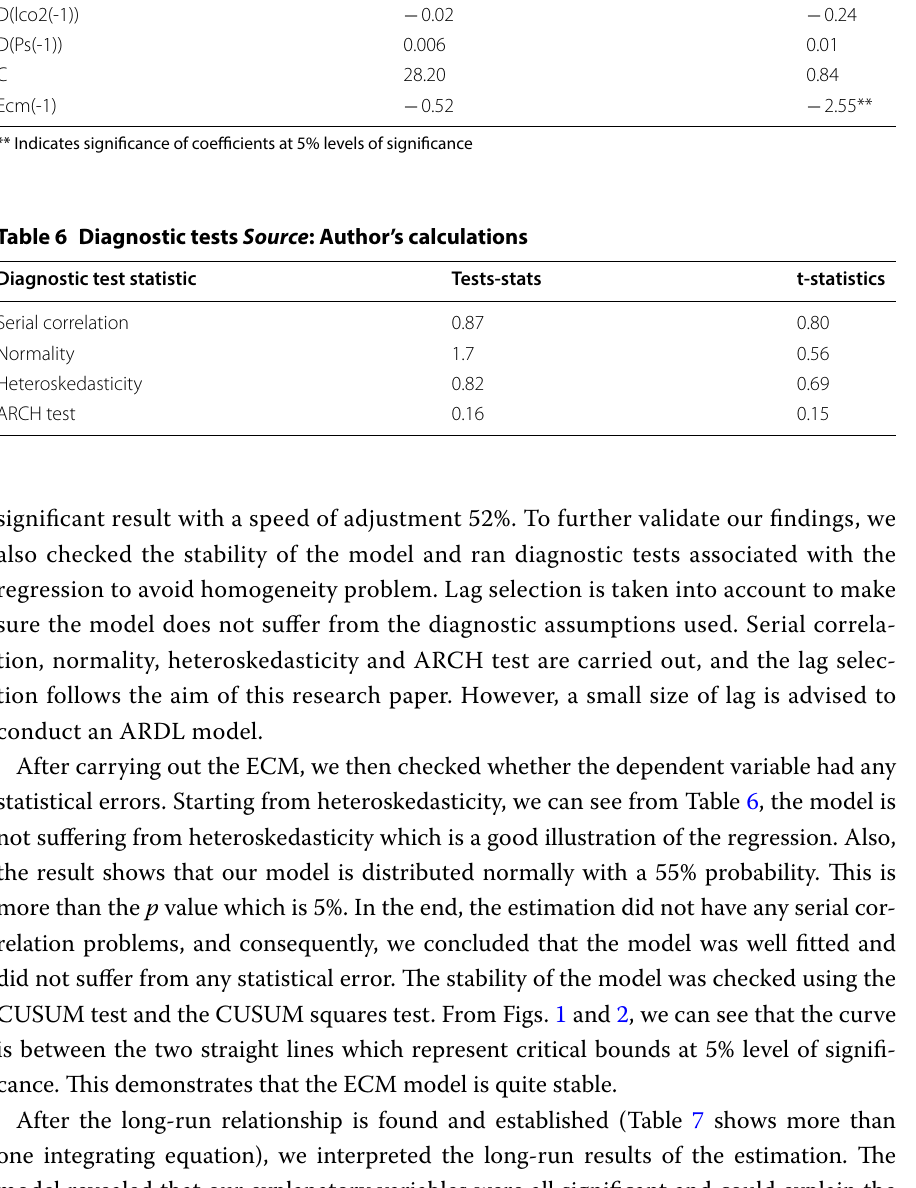
** Indicates significance of coefficients at 5% levels of significance